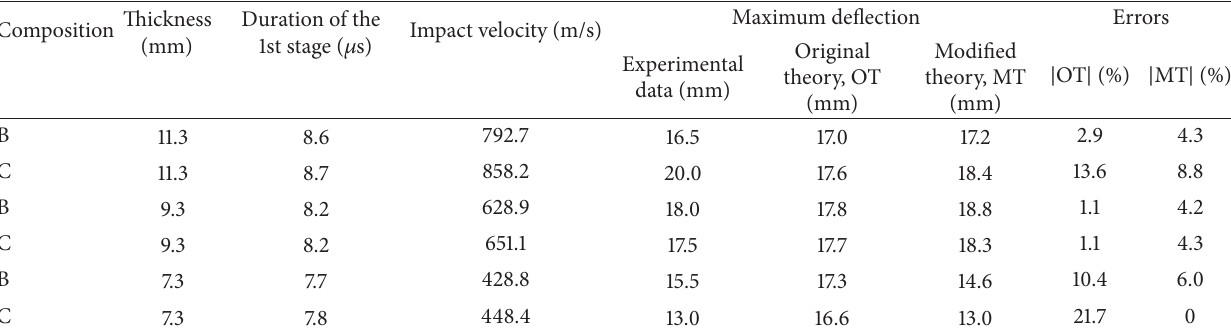
Table 6: Comparison of the former and new